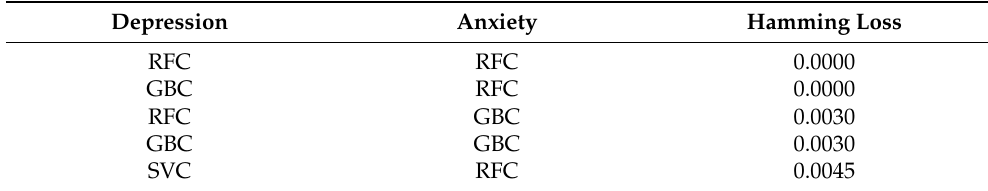
Table 13. Partial list of multi-label performance scores on training